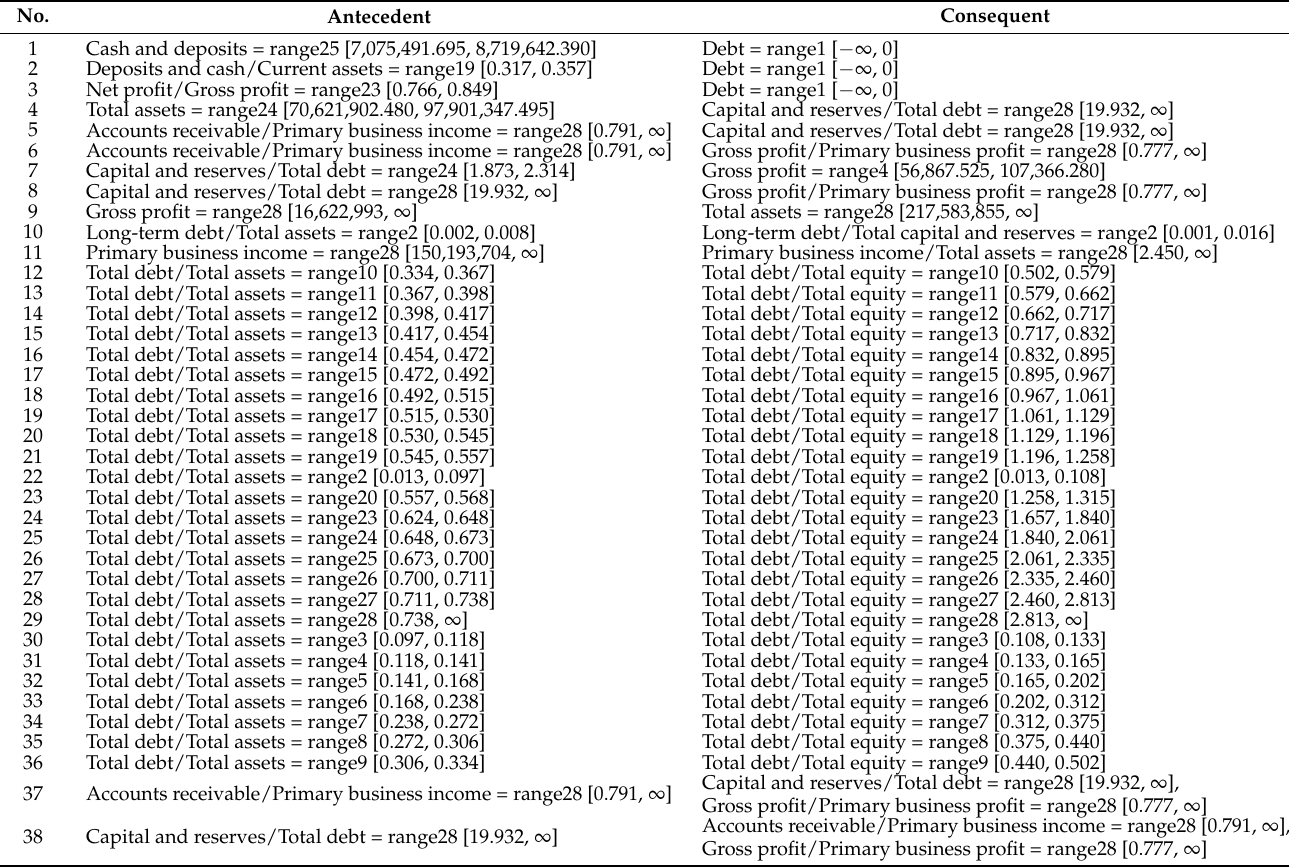
Table 5. Association rules from financial statement